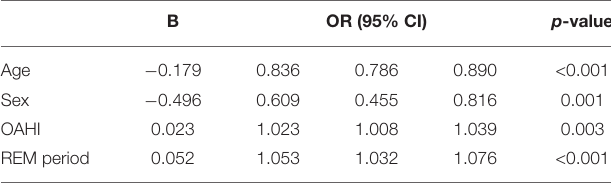
TABLE 5 | Multilevel binary regression results: predictors of a CAI > 1 in children with